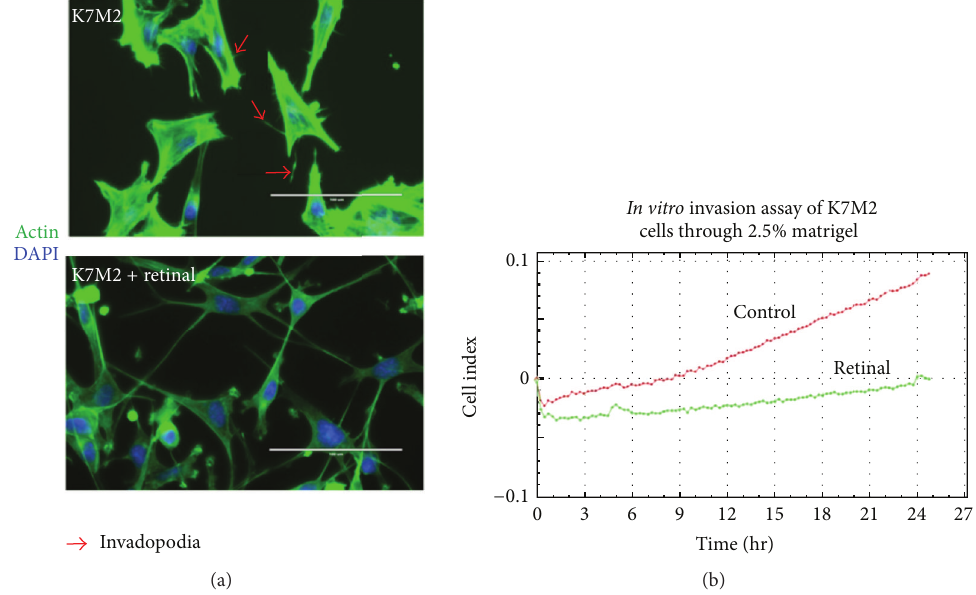
Figure 4: Retinal treatment of K7M2 cells changed migration-related cell morphological characteristics and decreased migration capacity. (a) Actin staining with phalloidin revealed that the cell morphology of K7M2 cells was modified with retinal treatment (5 𝜇 g/mL for 2 days), showing reduced presence of invadopodia. (b) In vitro invasion assay with 3D-matrigel (2.5%) revealed that K7M2 cells treated with retinal